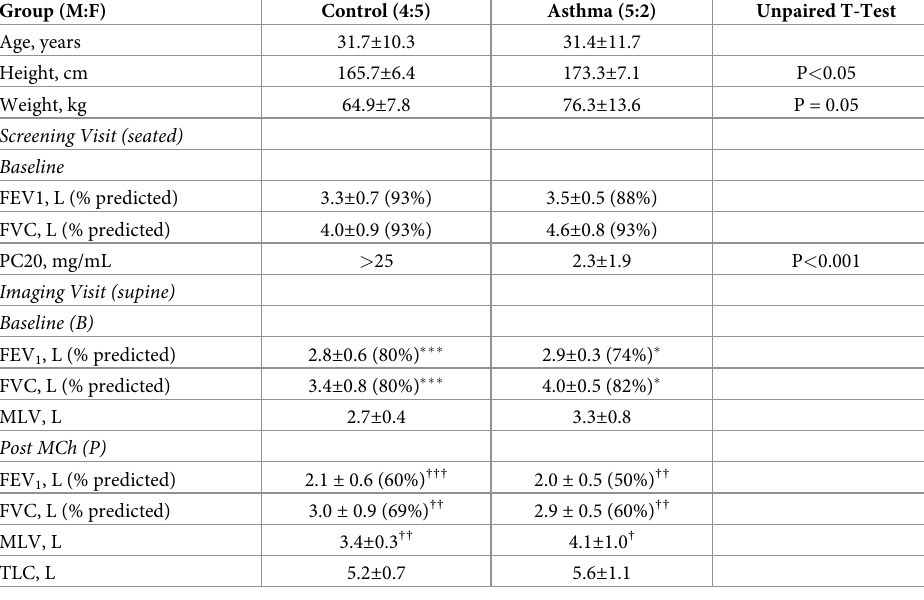
Table 1. Subject characteristics. Group